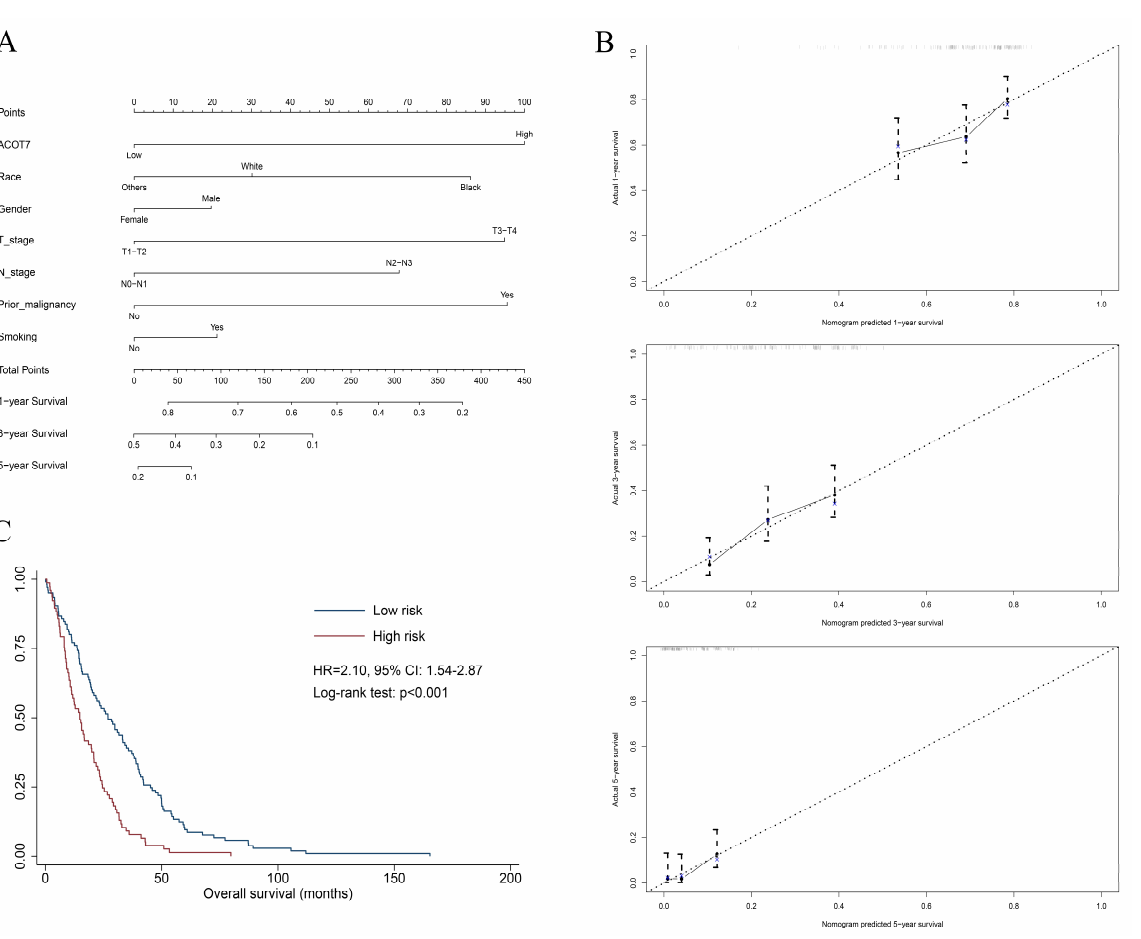
8 of 21 Table 1. Univariate and multivariate Cox regression analyses of ACOT7 and clinical characteristics in LUAD from TCGA database. Variables Univariate Multivariate HR with 95% CI p Value HR (95%) p Value ACOT7 (high vs. low)